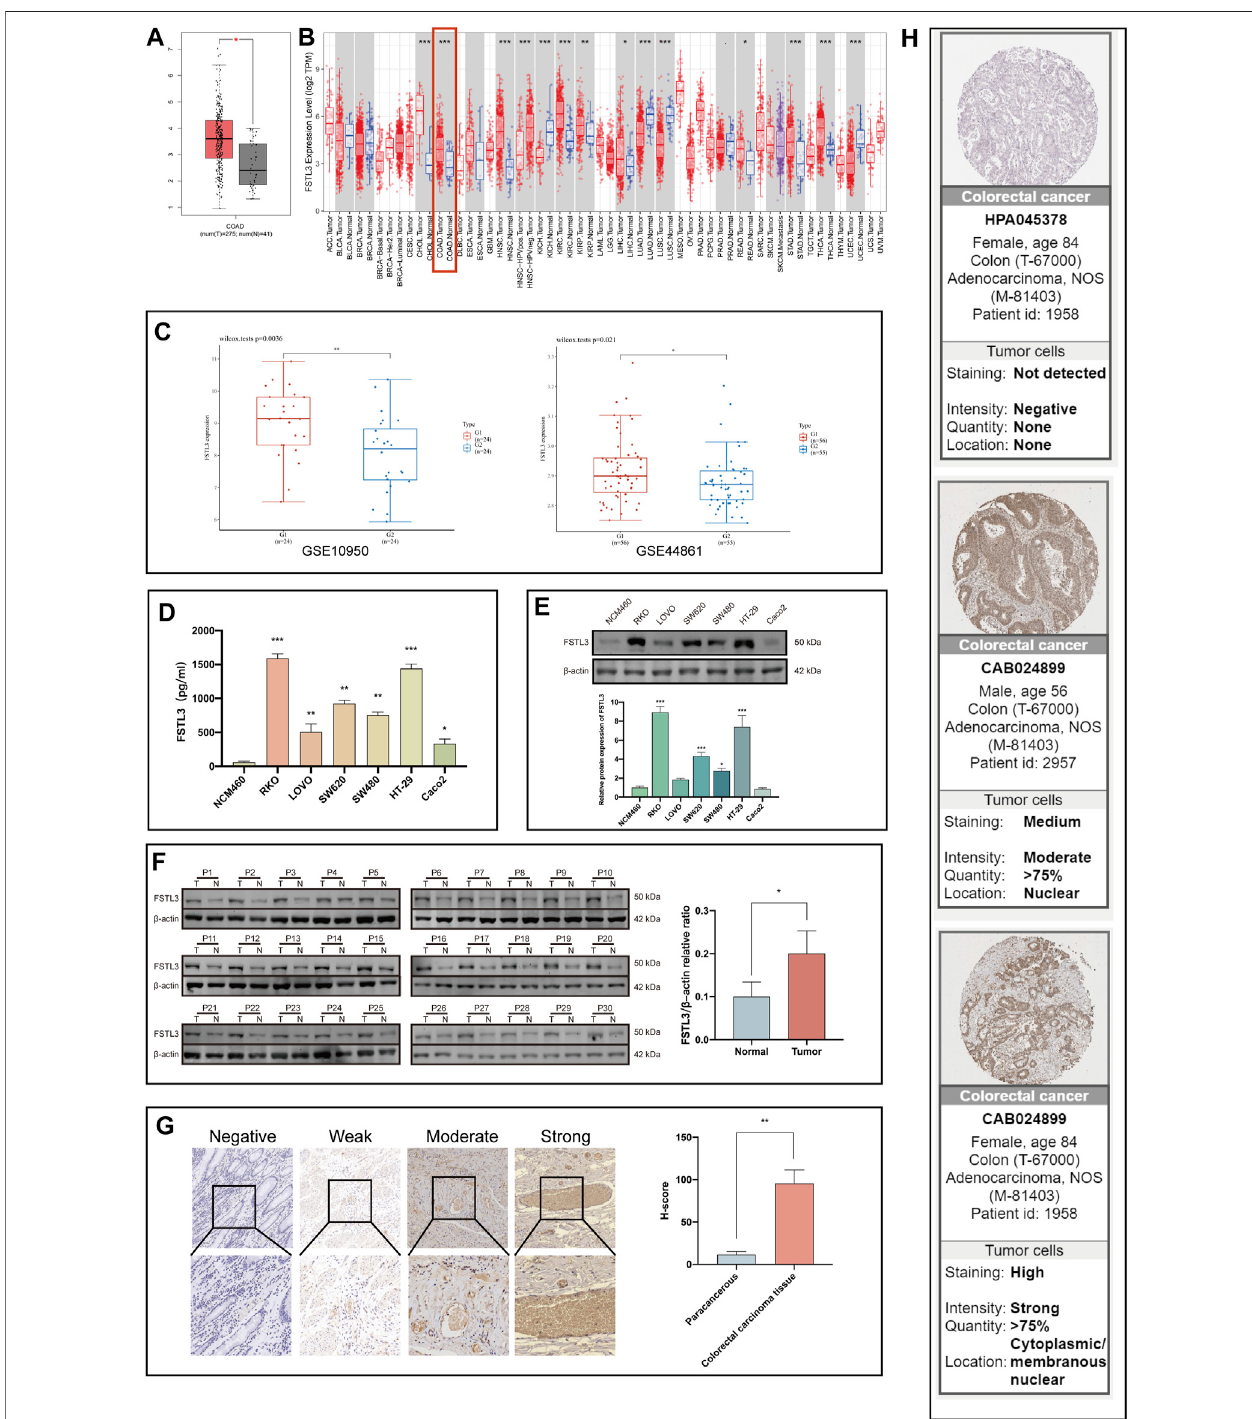
FIGURE 1 | FSTL3 levels in the colorectal cancer (CRC) tissues. (A) Expression levels of FSTL3 in CRC based on the data of the Cancer Genome Atlas (TCGA)- COAD. (B) The FSTL3 mRNAlevels in theCRC and normal tissues basedon theTIMER database. (C) Publicdatasets fromthe GeneExpressionOmnibus(GSE10950, GSE44861)wereusedtoverifythe FSTL3 mRNAlevelsinCRC. (D,E) TheFSTL3proteinexpressioninthenormalhumancolonicepithelialcellsaswellastheCRCcells. (F) FSTL3 expression in the CRC tissues (T) and paired non-tumorous tissue (N) evaluated using western blotting ( n (cid:2) 30). (G) The intensity of FSTL3 immunohistochemistrystainingandFSTL3expressionlevelsintheparacancerousandCRCtissues( n (cid:2) 30). (H) TheFSTL3immunohistochemistryintheCRCtissuesis based on data from the Human Protein Atlas (THPA). * p < 0.05, ** p < 0.01, *** p < 0.001.